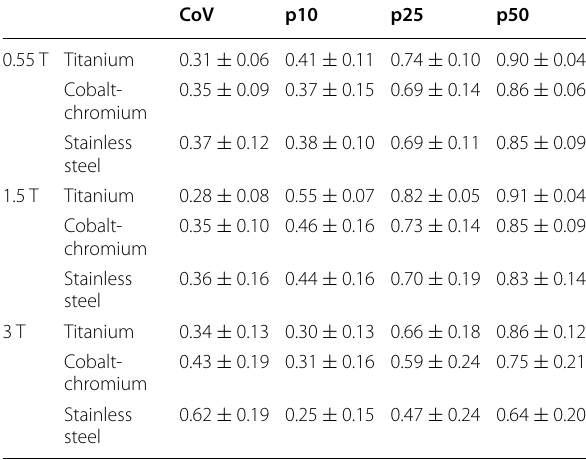
Table 4 Coefficient of variation and fraction of voxels within a 10% (p10), 25% (p25), and 50% (p50) limit above or below mean signal intensity within the phantom at 0.55 T, 1.5 T, and 3 T. No statistically significant differences